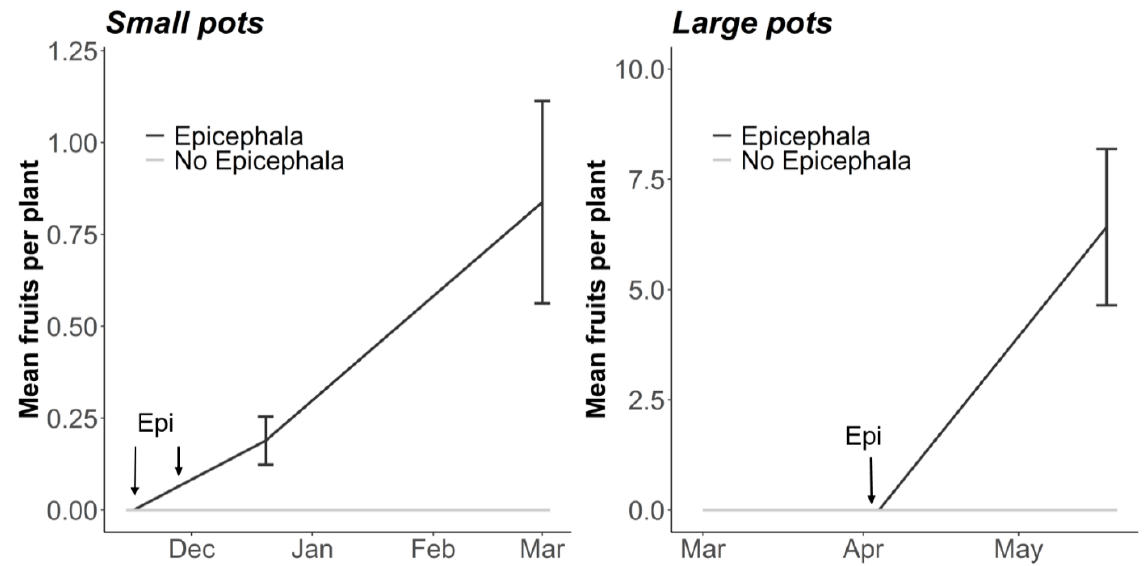
Figure 3. Mean number (± SE) of mature fruits per plant in two independent replicated trials (small and large pots) grown with (N = 36) and without Epicephala pollinators (N = 36). Small pot and large pot replicates were included to maximise the likelihood of flowering in young plants (see methods). The date of Epicephala moth introductions are shown (Epi).